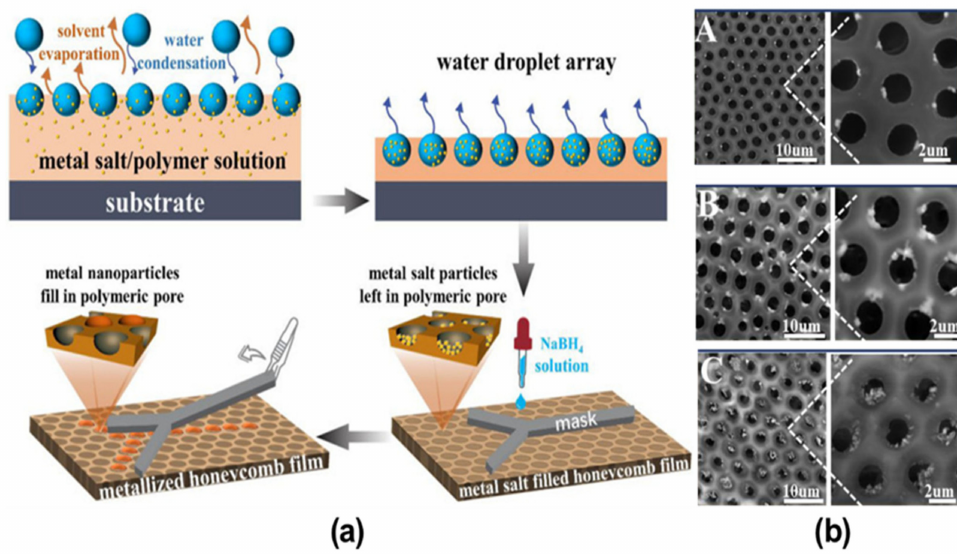
Figure 8. ( a ) The schematic representation showing the fabrication of the metal–NPs-functionalized honeycomb films. ( b ) SEM images of the HCP films filled with metal NPs: Au (A), Ag (B), and Cu (C). Reprinted with permission from ref. [97]. Copyright 2021 Polymers.